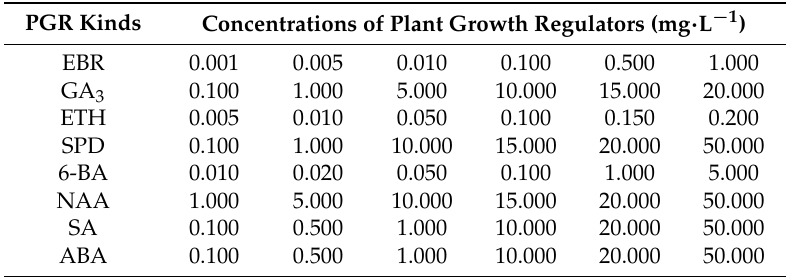
Table 2. The final concentrations gradients of plant growth regulators were added into algae solution. PGR